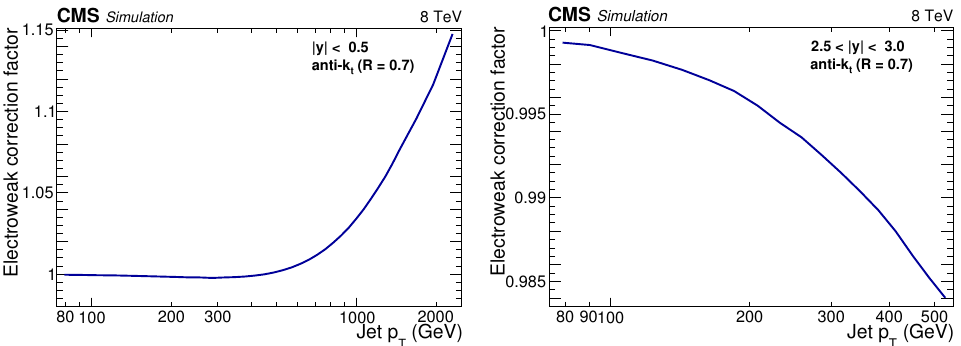
Figure 2 . Electroweak correction factor for the central (left) and outermost (right) rapidity bins as a function of jet p T